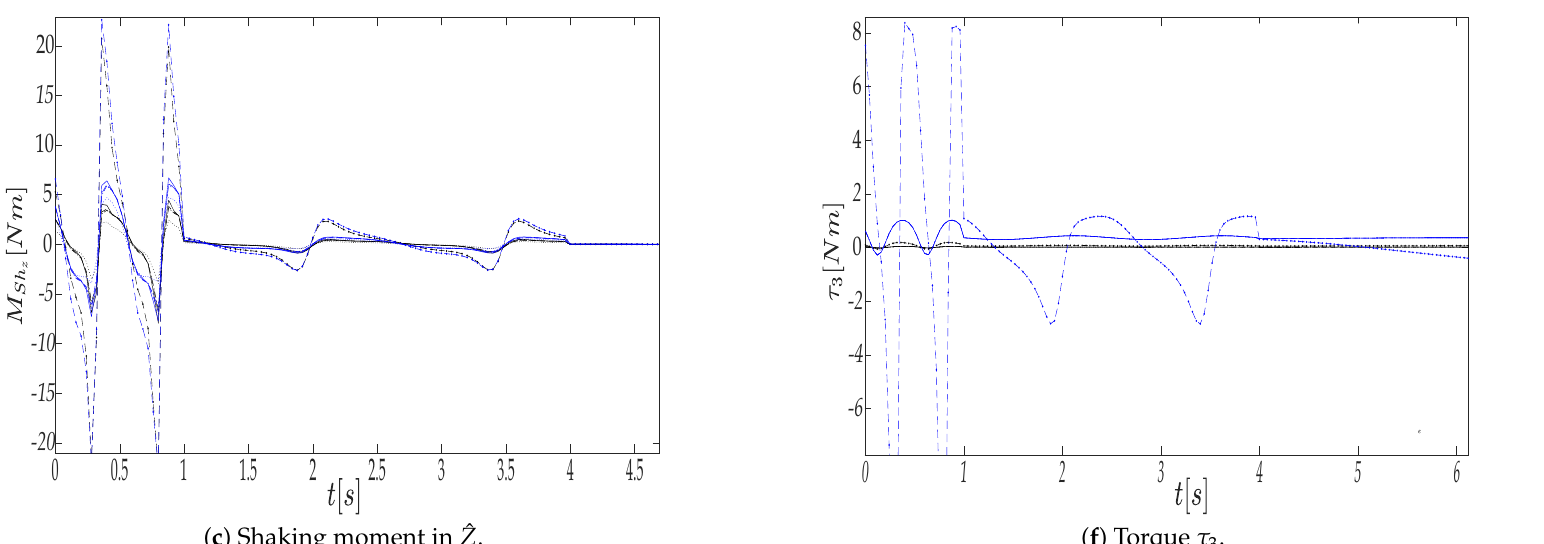
Figure 10. Behavior of the shaking force F Sh , shaking moment M Sh , and torque τ for the designs with different velocities and two different end-effector masses in z the circular trajectory. The design behaviors associated with m e = 0 kg are described in lines as RBD, − · − · − DBD, − − −− DTBD, · · · · ·· SMBD, − · − · − SFBD. The design behaviors associated with m e = 0.5 kg are described in lines as RBD, − · − · − DBD, − − −− DTBD, · · · · ·· SMBD, − · − · −